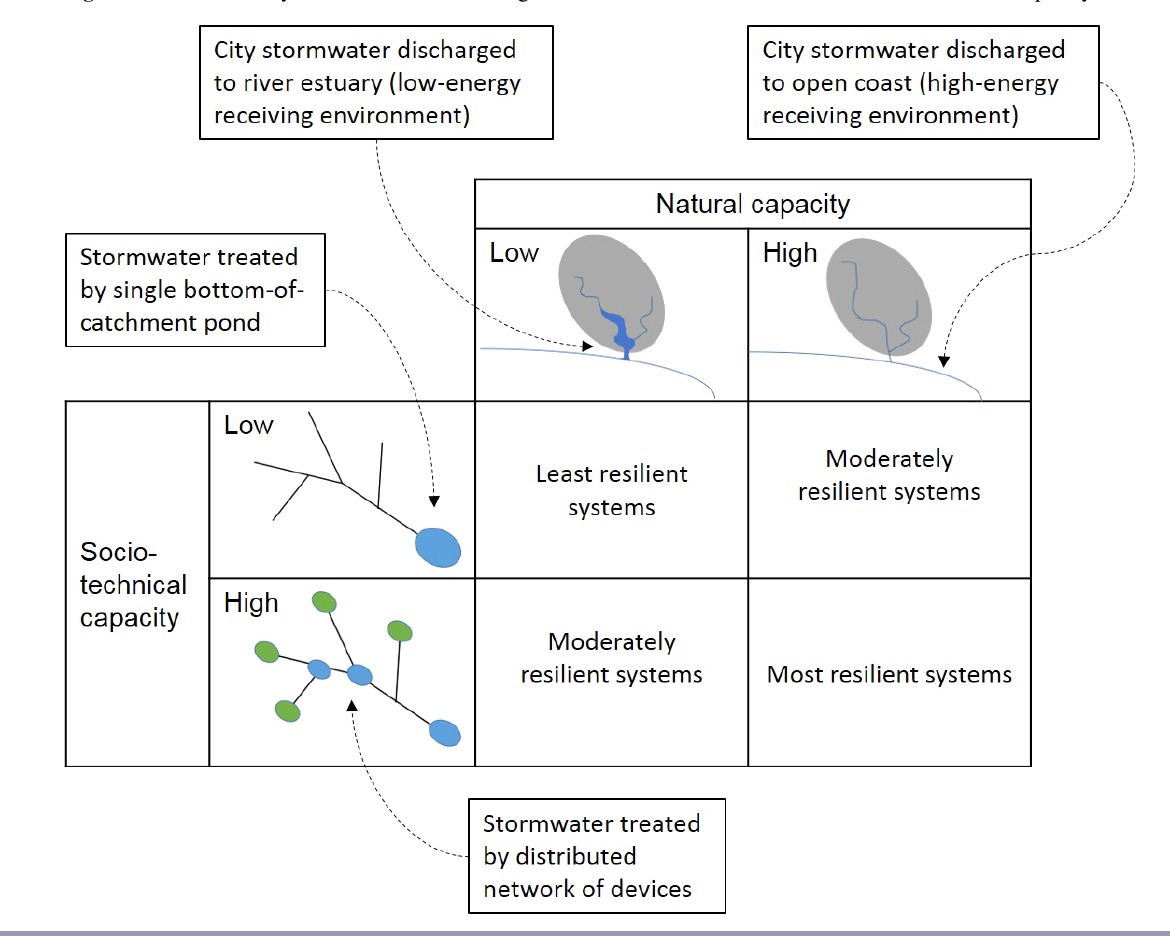
Fig. 1 . Assessment of system resilience according to the combination of socio-technical and natural